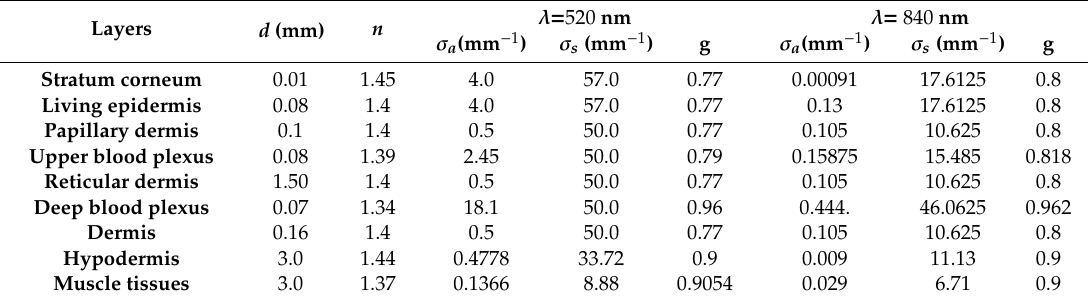
Table 1. Thickness, absorption coe ffi cient, scattering coe ffi cient and anisotropic factor of a skin model at 520 and 840 nm [21,27–29].